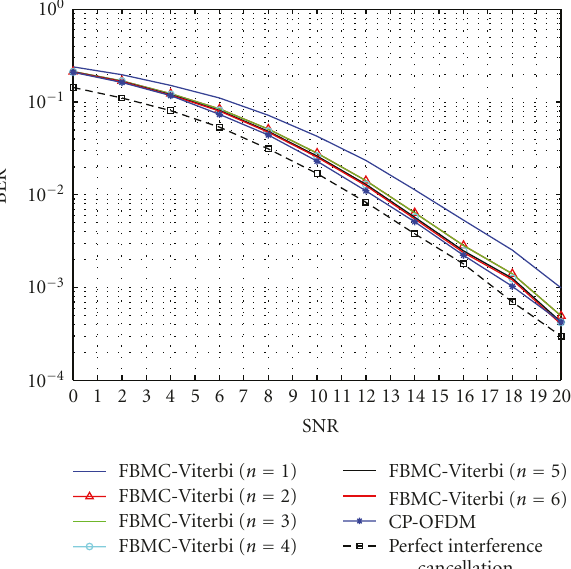
Figure 5: Performance of single delay STTC with 2 transmit anten- nas and one receive antenna (FBMC and CP-OFDM modulation).